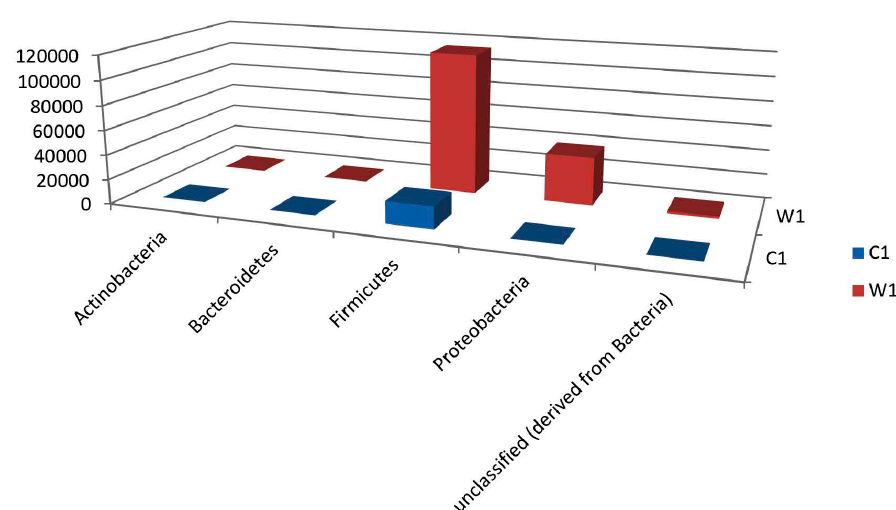
Fig. 8. Krona plot of Phylum level distribution